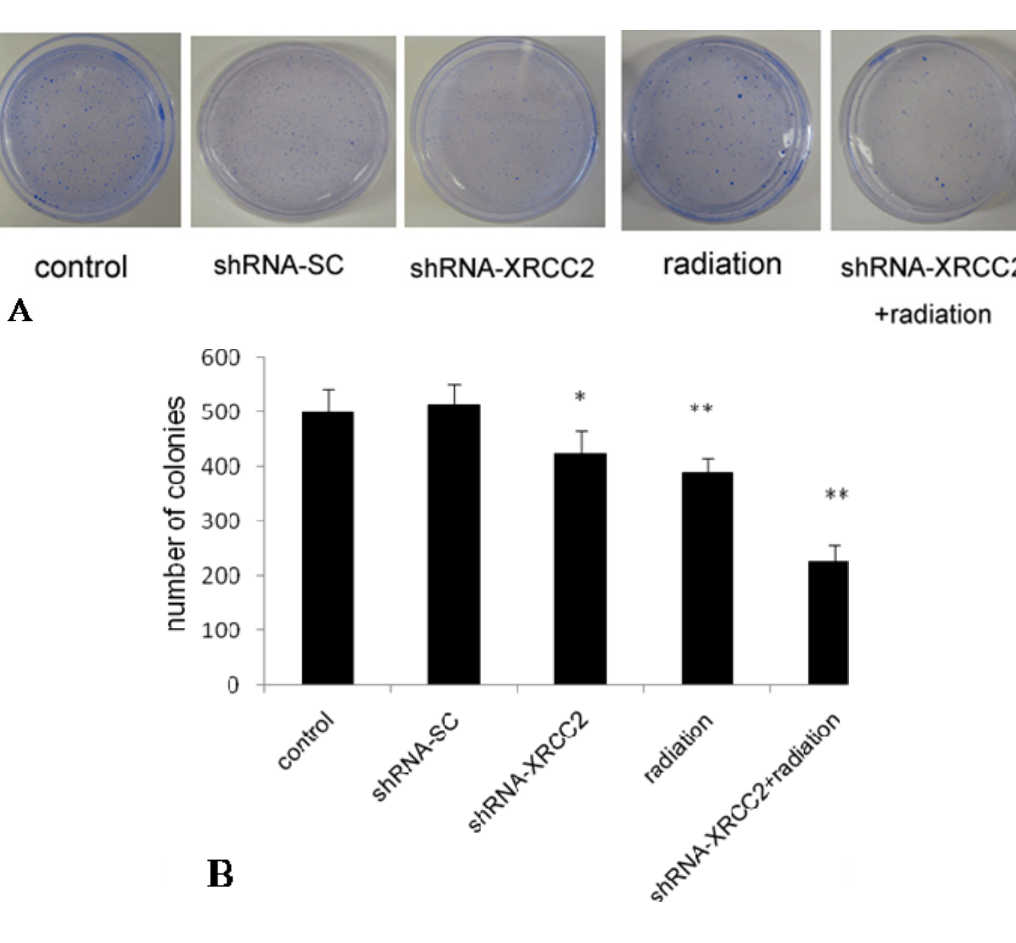
Figure 4. Knockdown of XRCC2 by shRNA enhanced radiosensitivity to X-radiation of T84 cells. ( A ) Photographs of colonies; and ( B ) the number of colonies. Cells were treated with either shRNA-XRCC2, shRNA-SC, radiation or shRNA-XRCC2 combined radiation. Cells of control group, shRNA-SC group and shRNA-XRCC2 group were not exposed to radiation. Cells of radiation group were treated with 8 Gy X-ray radiation after T84 cells attached. shRNA-XRCC2 combined radiation group received 8 Gy radiation at 12 h after shRNA-XRCC2 transfection. The effect of XRCC2 suppression on radiosensitivity of T84 cell line was examined by colony formation assay. The values are presented as the mean ± SD ( n = 6). * p < 0.05, ** p < 0.01 compared with the control